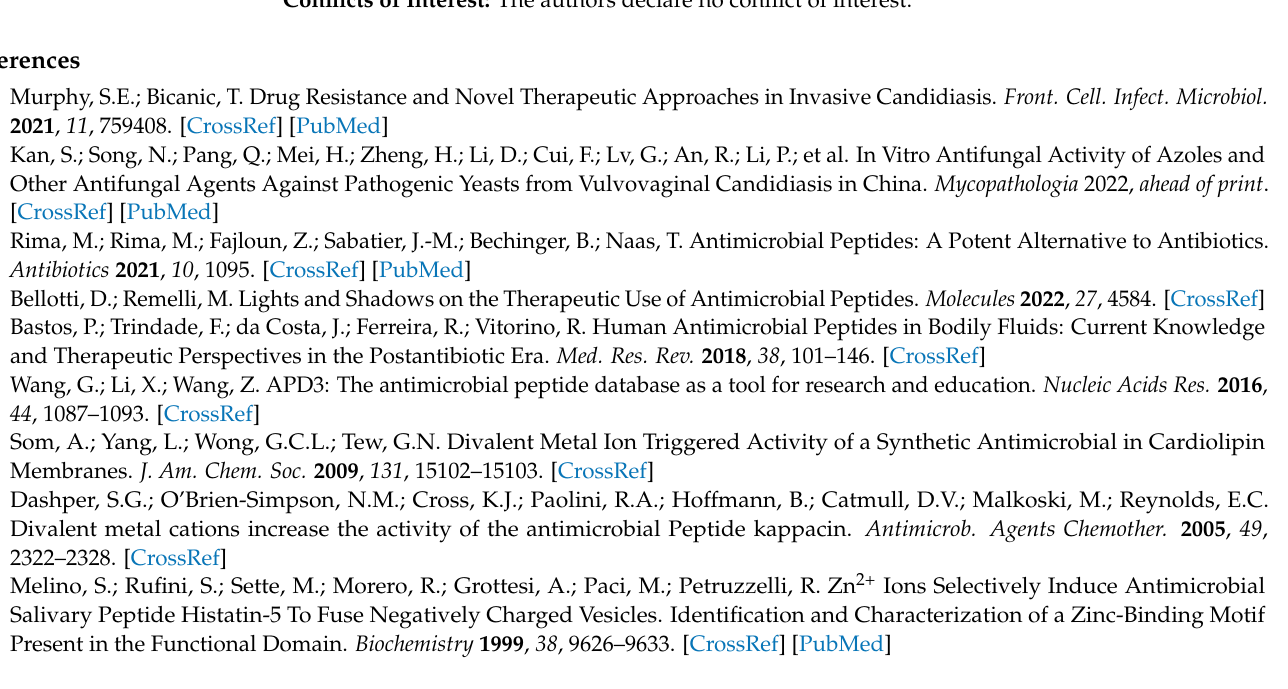
Table S2: Kinetic release data of